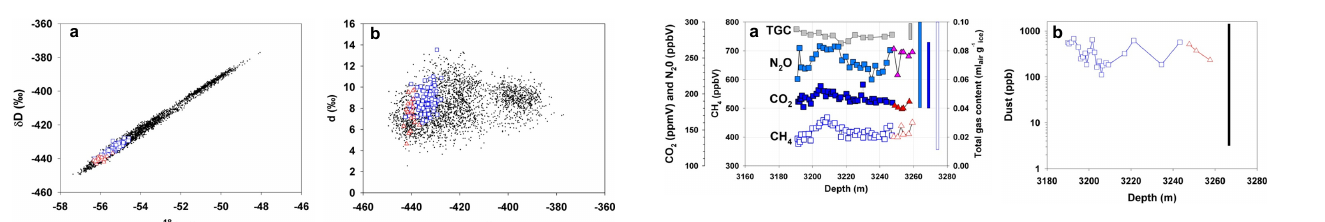
Figure 3. Gas and dust properties of the clean (squares) and dis- persed (triangles) basal ice facies at EPICA Dome C: (a) total gas content (mL air g − 1 , grey), methane (ppbV, white), nitrous oxide ice (ppbV, light blue) and carbon dioxide (ppmV, dark blue) – verti- cal bars of equivalent shading cover the full concentration range observed for CH 4 , CO 2 , N 2 O and total gas content during the pre- ceding climatic cycles, (b) dust concentrations (ppb) – the black vertical bar covers the full concentration range during the previous climatic